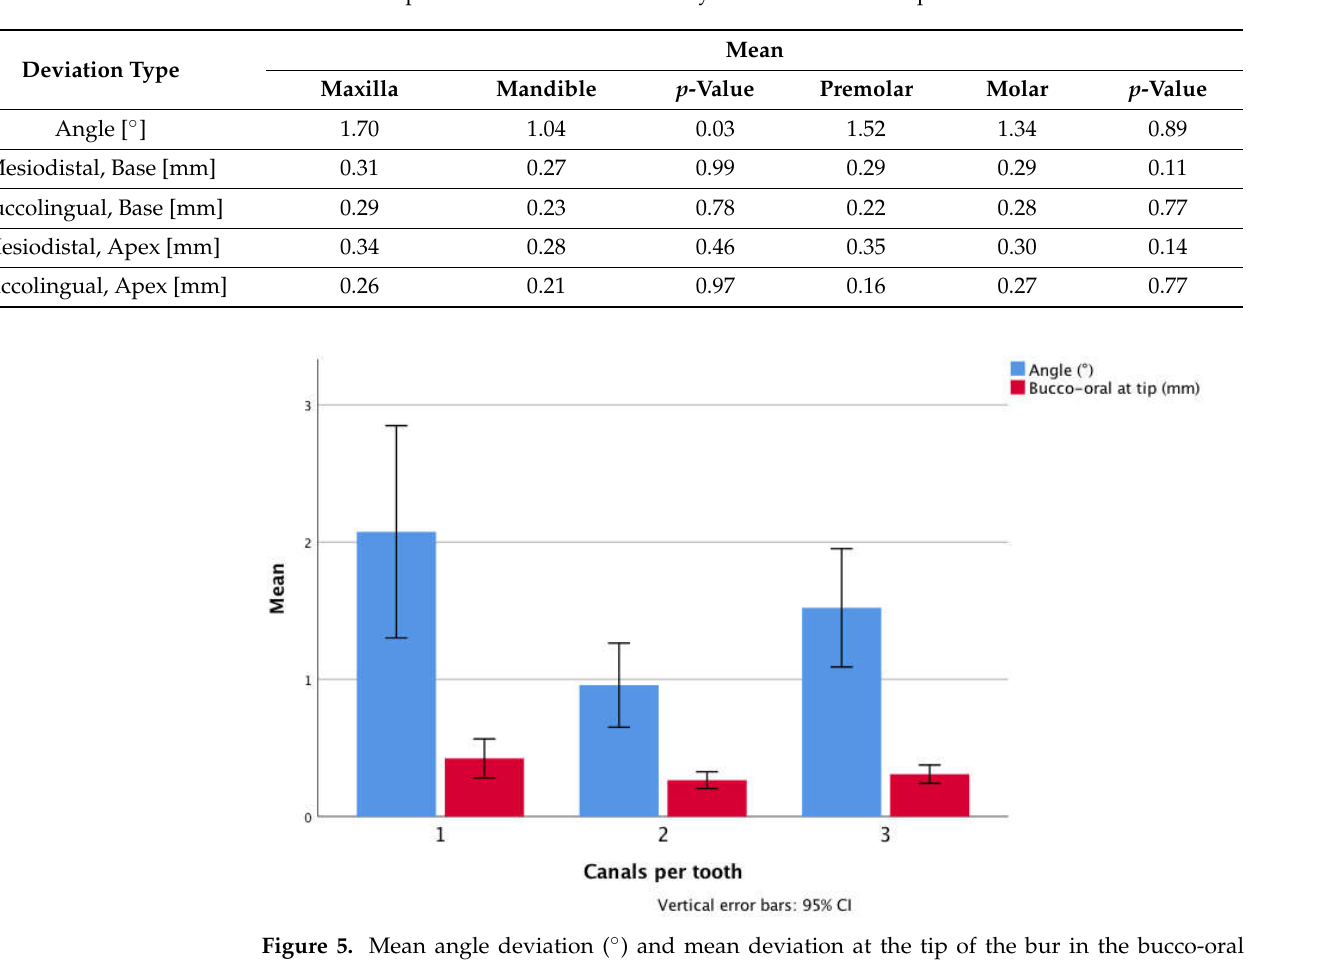
Table 2. Mean angle deviation (°) and deviation in the mesio-distal and bucco-oral direction (mm) at the base and tip of the bur between maxillary vs. mandibular and premolar vs. molar teeth.